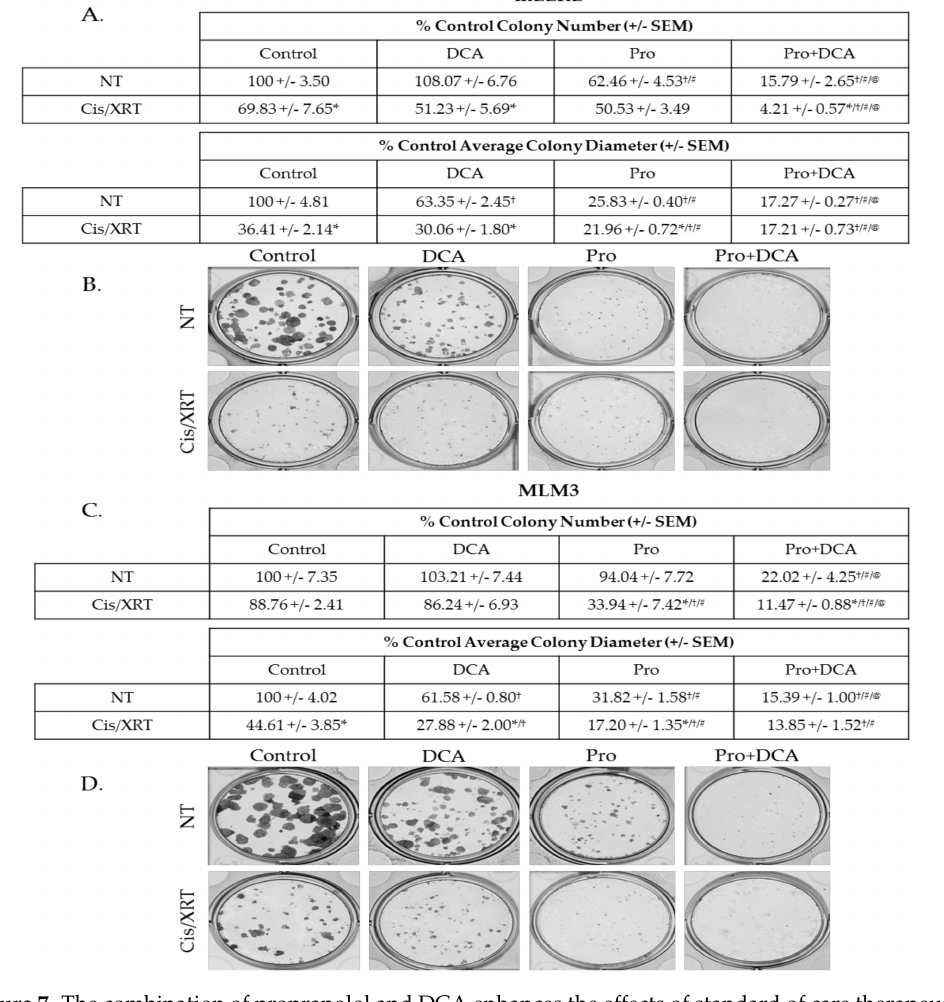
Figure 7. The combination of propranolol and DCA enhances the effects of standard of care therapeutic modalities and sensitizes chemoradioresistant cells to cisplatin and radiation. Colony-forming assay results and representative images of mEERL ( A , B ) and MLM3 cells ( C , D ) treated with propranolol (40 µ M) and/or DCA (10 mM) concurrent with 2 µ M cisplatin and 8 Gy X-ray radiation (Cis/XRT). NT = not treated with Cis/XRT. Values reflect % colony number (top) or % average colony diameter (bottom) relative to untreated controls. Each value represents mean +/- SEM of n = 4 independent biological replicates; p -values reflect t -test results (* p ≤ 0.05 comparing NT vs. Cis/XRT in the same column (e.g., DCA NT vs. DCA Cis/XRT); † p ≤ 0.003 vs. control cells in the same row (e.g., Control NT vs. DCA NT); # p ≤ 0.01 vs. DCA-treated cells in the same row; (e.g., DCA Cis/XRT vs. Pro